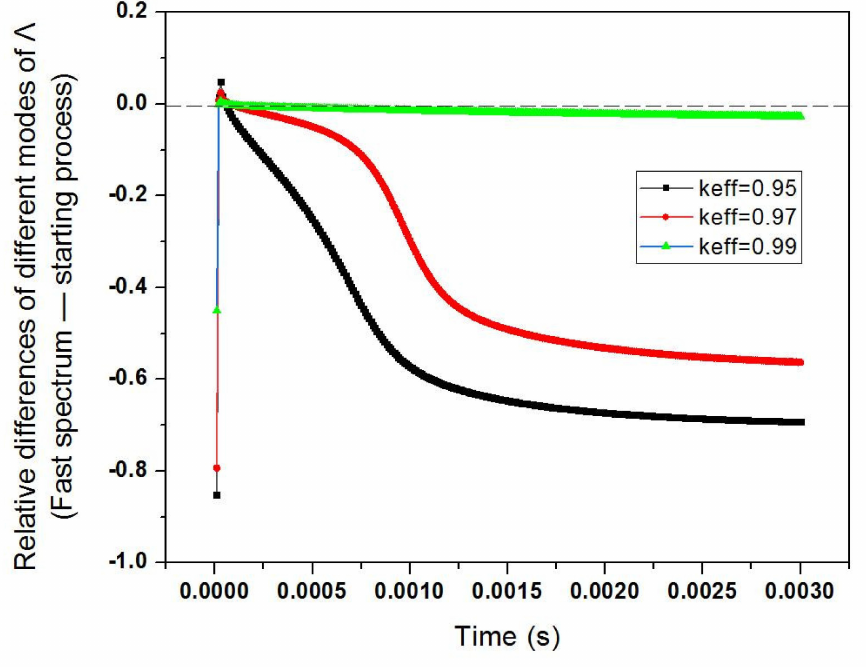
Figure 6. Relative differences in Λ with time for different modes of the fast spectrum, under different subcriticalities and starting